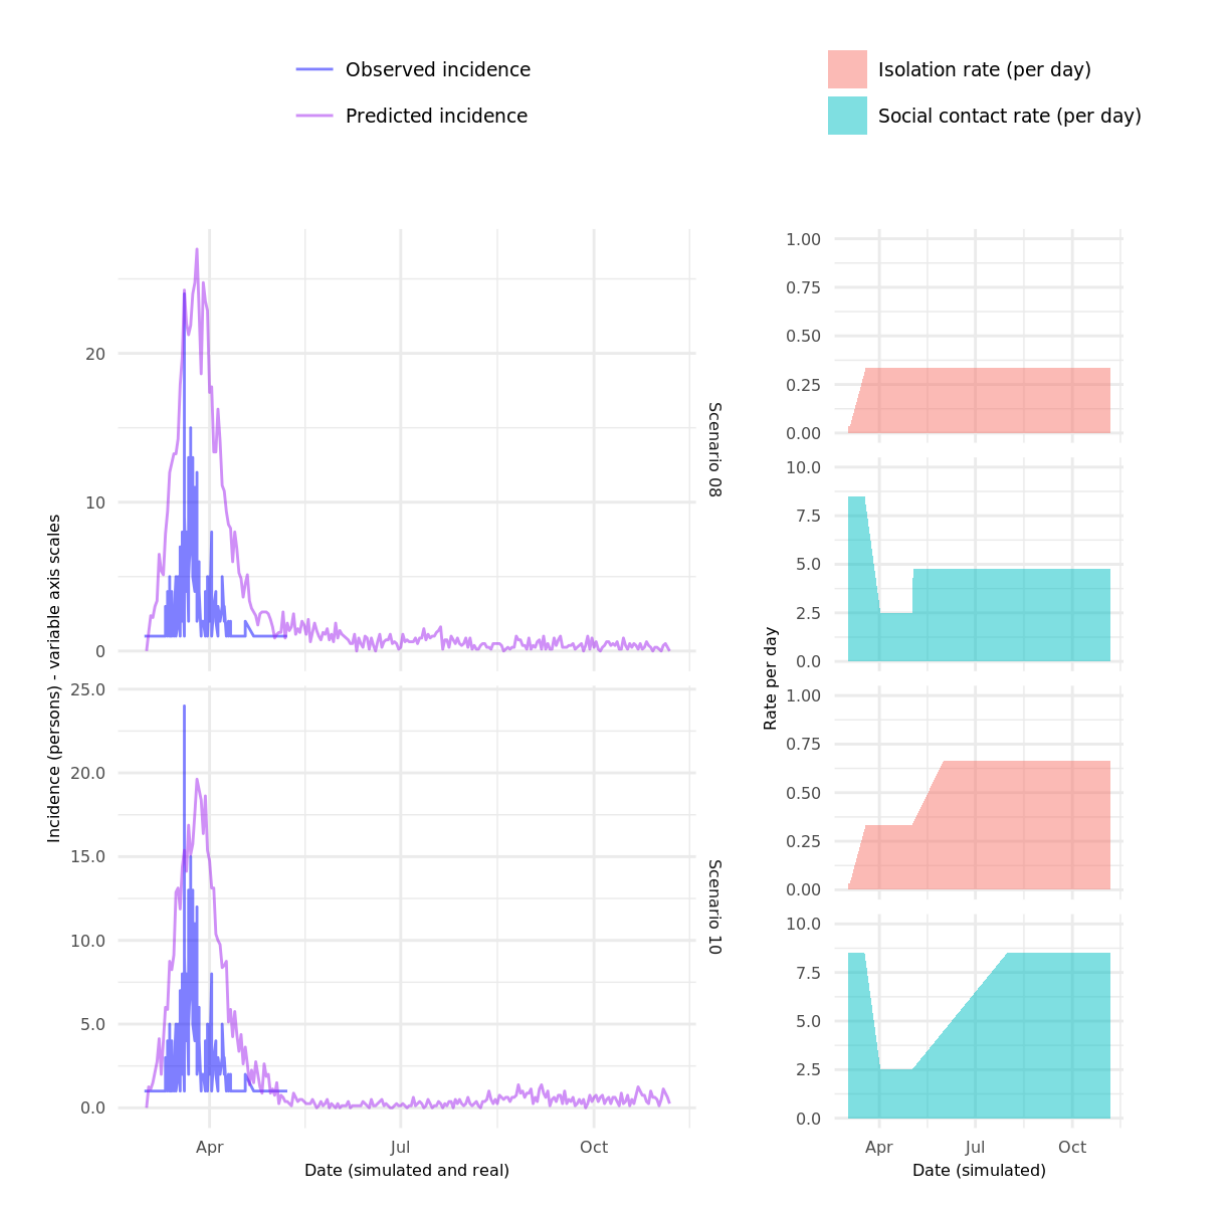
Figure 7. Details for scenarios 08 and